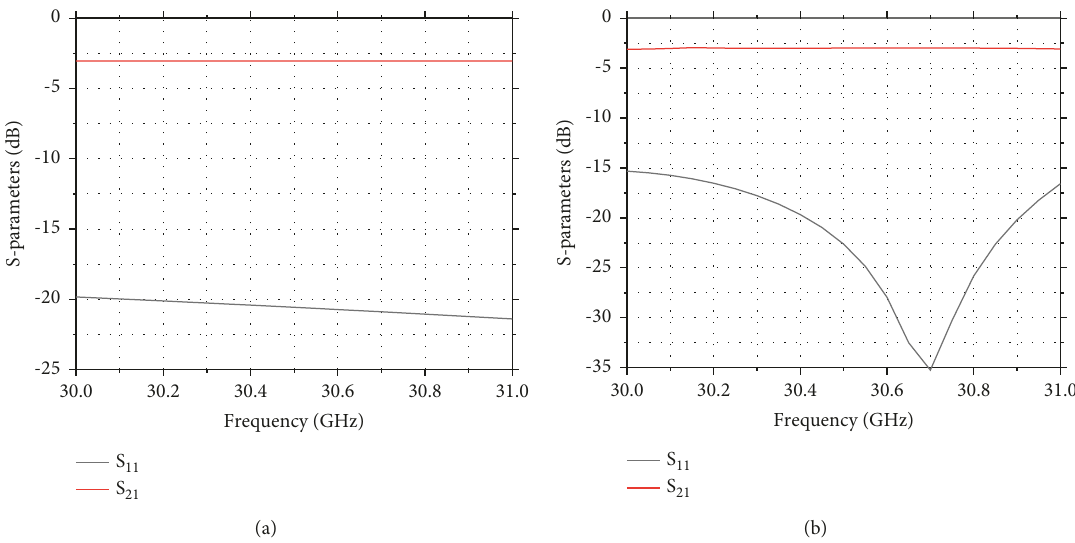
Figure 5: Simulated reflection and transmission coefficients of the (a) E-plane power divider and (b) H-plane power divider.